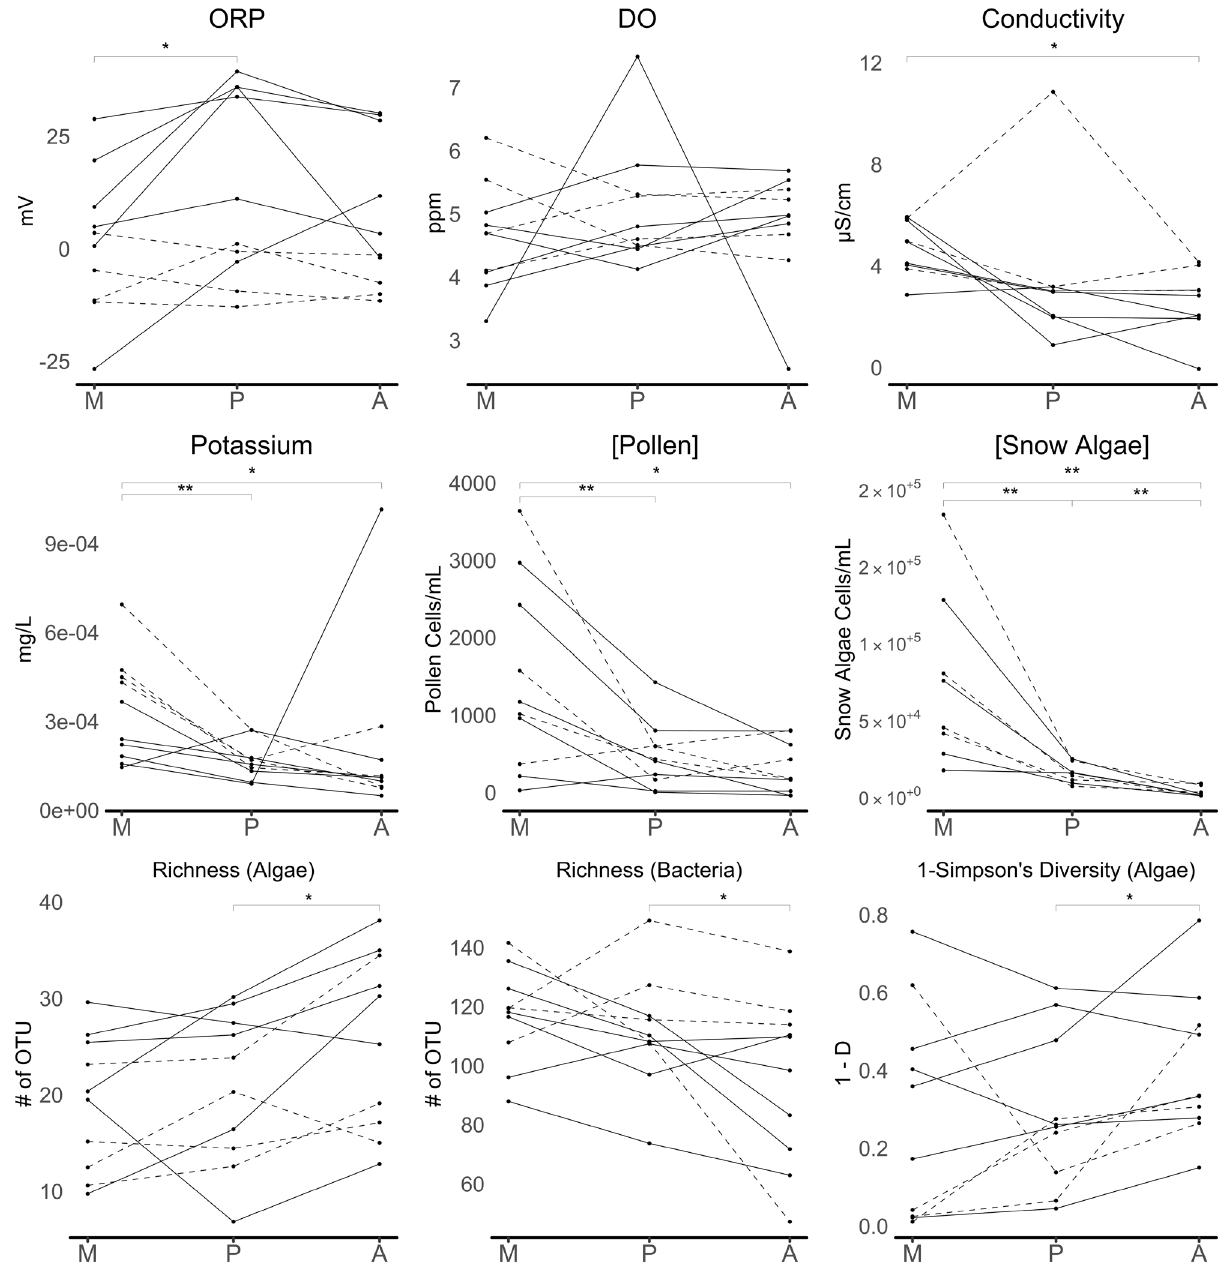
Figure 2. Parallel plots showing significantly different Wilcoxon Rank-Sum tests of environmental traits and diversity estimators between paired snow algae bloom zones M, P and A (* for p < 0.05 and ** for p < 0.01) and the Cascades and Rockies (solid and dashed lines respectively). Parameters not included were not found to have pairwise significance differences or may have been influenced by outliers. Even though not significant, DO was shown as M nearly met the cutoff for significance for between M-P and M-A (see text). Points represent individual